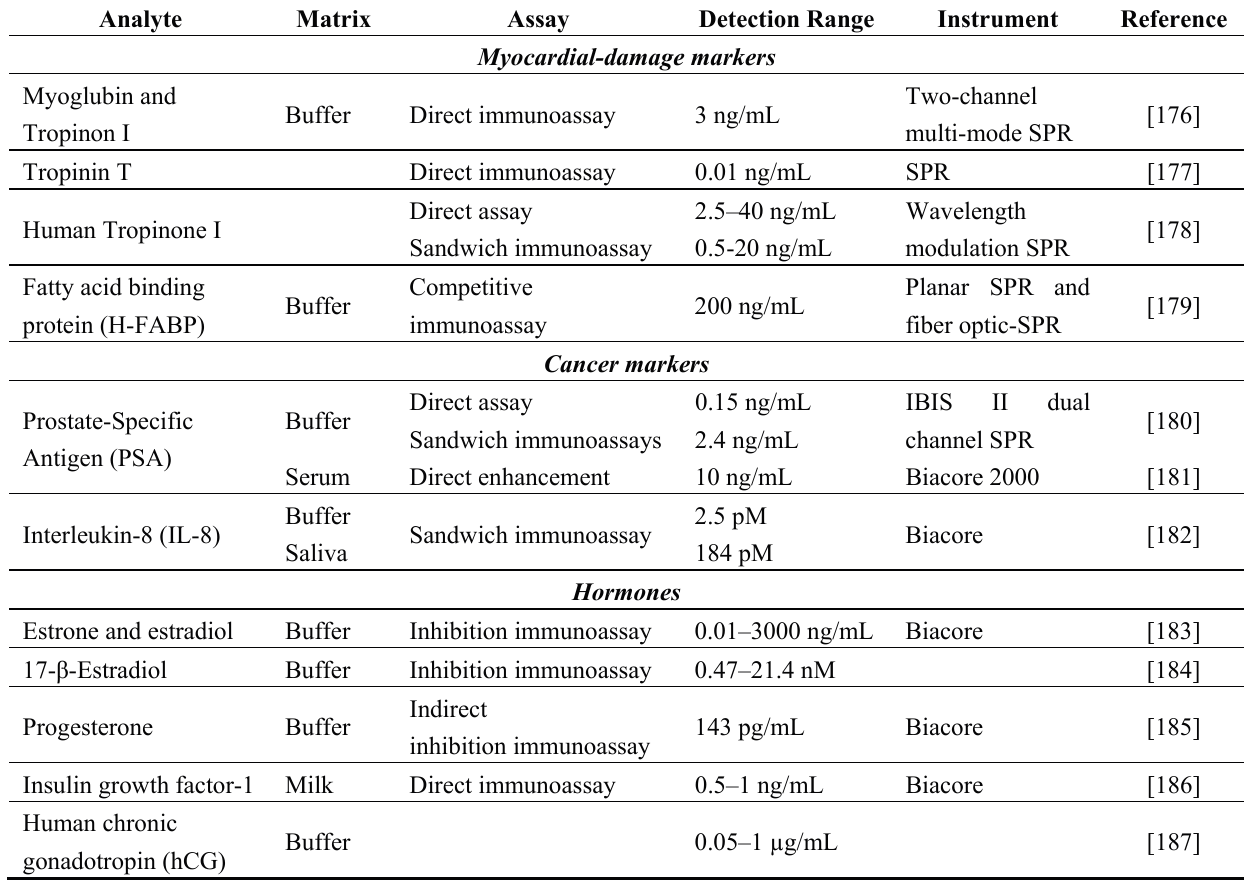
Table 9. SPR biosensors for biomedical-analyte